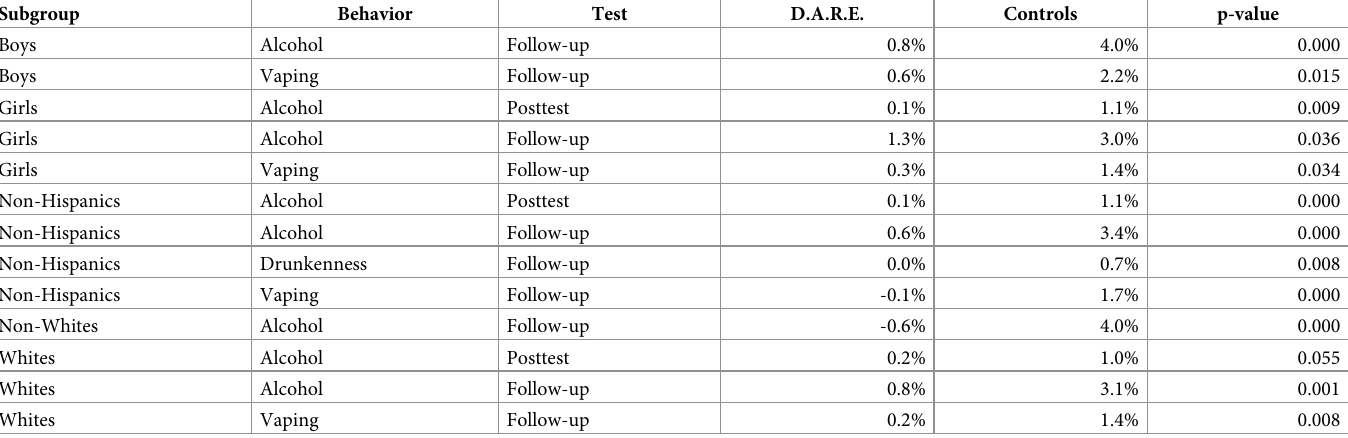
Table 4. Subgroup analyses where D.A.R.E.-exposed student differed significantly from virtual controls * .